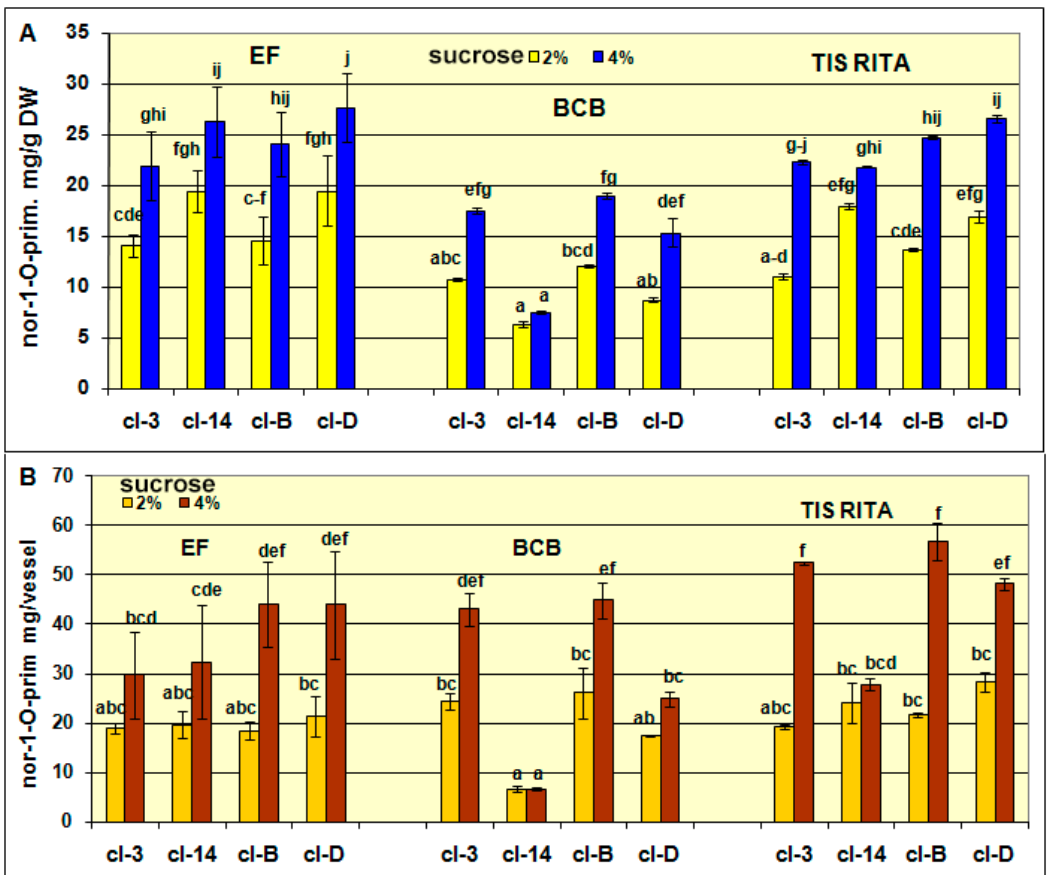
Figure 4. The content of norswertianin-1- O -primeveroside in hairy root clones cl-3, cl-14, cl-B, and cl-D, after 7 weeks of cultivation in Erlenmeyer flasks (EF), bubble column bioreactor (BCB) and temporary immersion systems (TIS) RITA ® . ( A ) The contents are presented as mg/g of dry weight and ( B ) the contents are presented as mg per vessel (bioreactor). Values are expressed as mean ± SE ( n = 3–5). The different letters above bars denote significant difference by Fisher’s least significant difference (LSD) test, p ≤ 0.05.